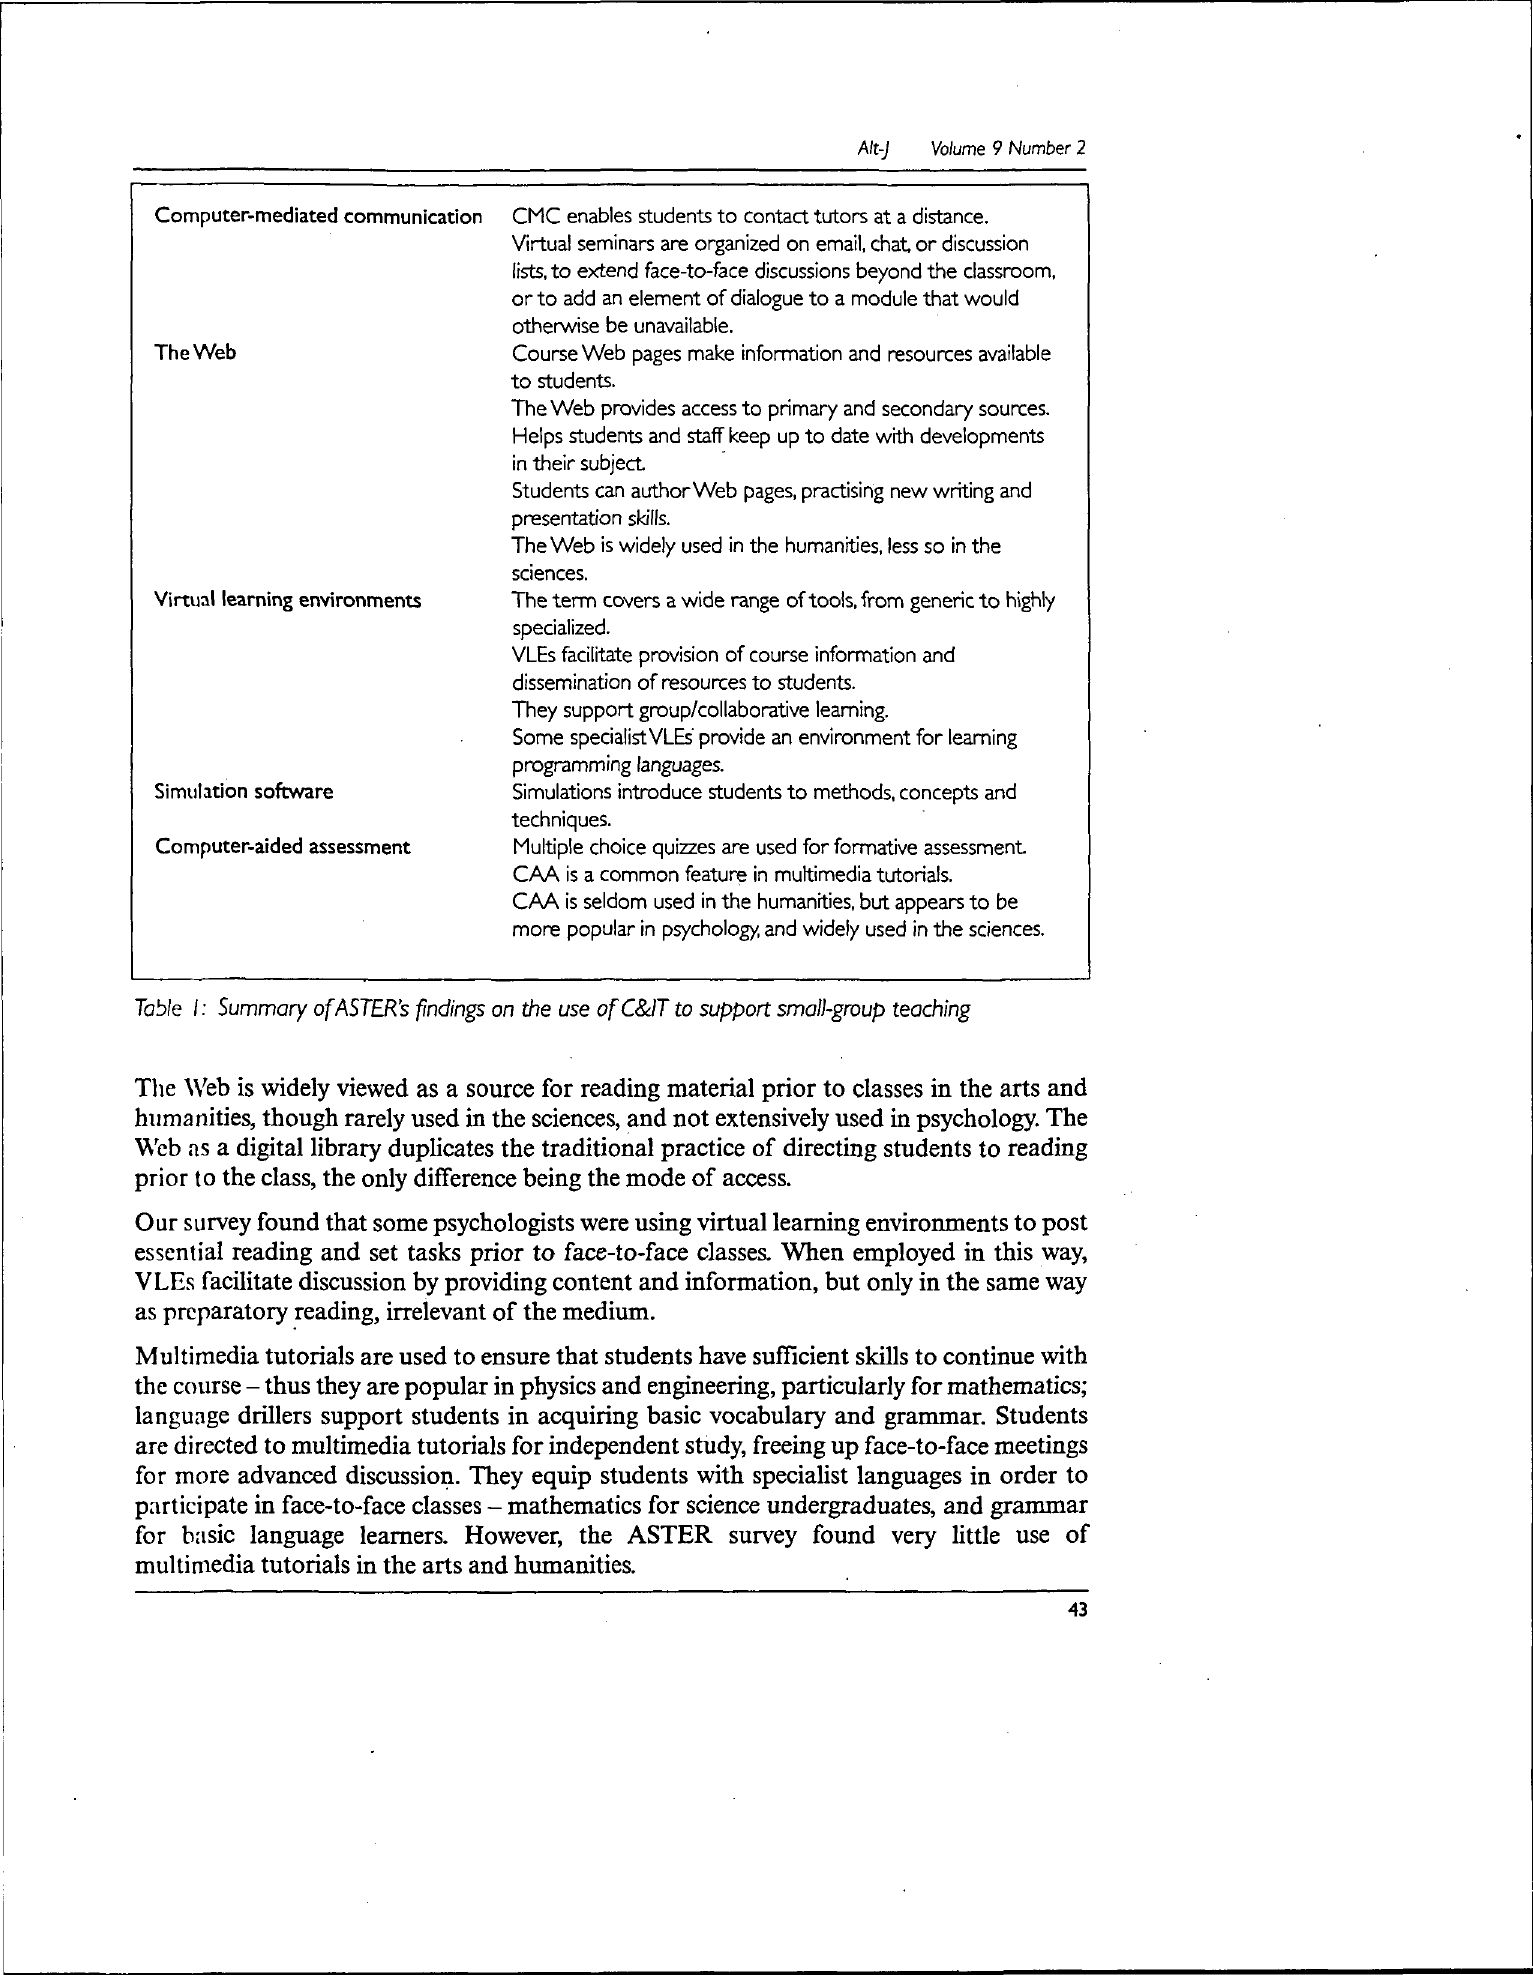
Table I: Summary ofASTER's findings on the use ofC&IT to support small-group teaching The Web is widely viewed as a source for reading material prior to classes in the arts and humanities, though rarely used in the sciences, and not extensively used in psychology. The Web as a digital library duplicates the traditional practice of directing students to reading prior to the class, the only difference being the mode of